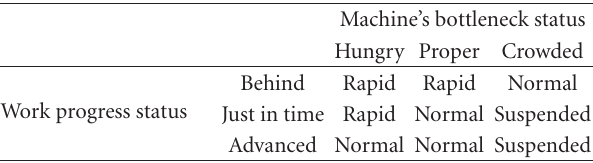
Table 2: The job speed